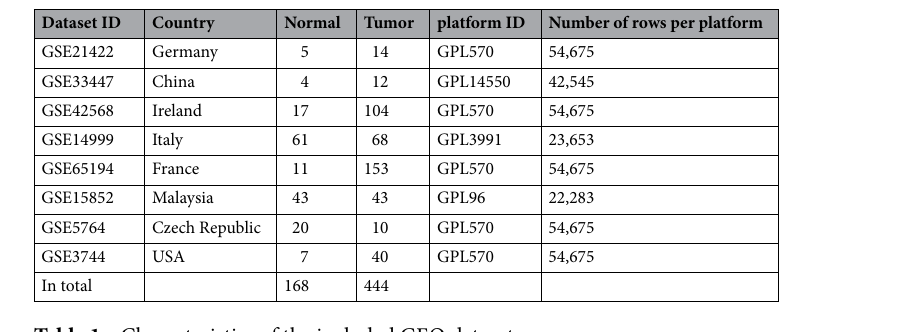
Table 1. Characteristics of the included GEO